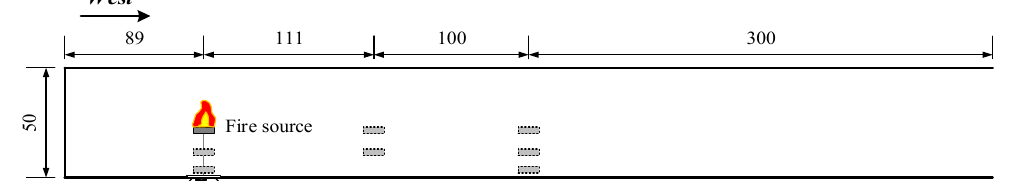
Figure 7. Schematic diagram of the model-scale test rig (dimensions in cm).